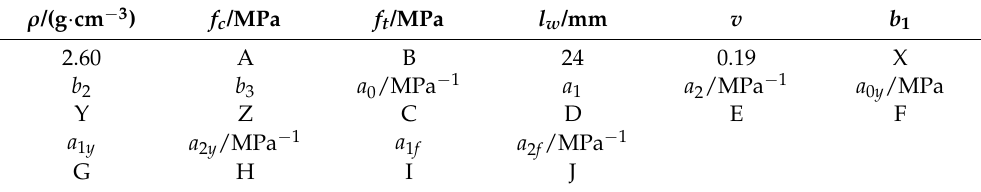
Table 6. Main parameters of the improved K&C material model.